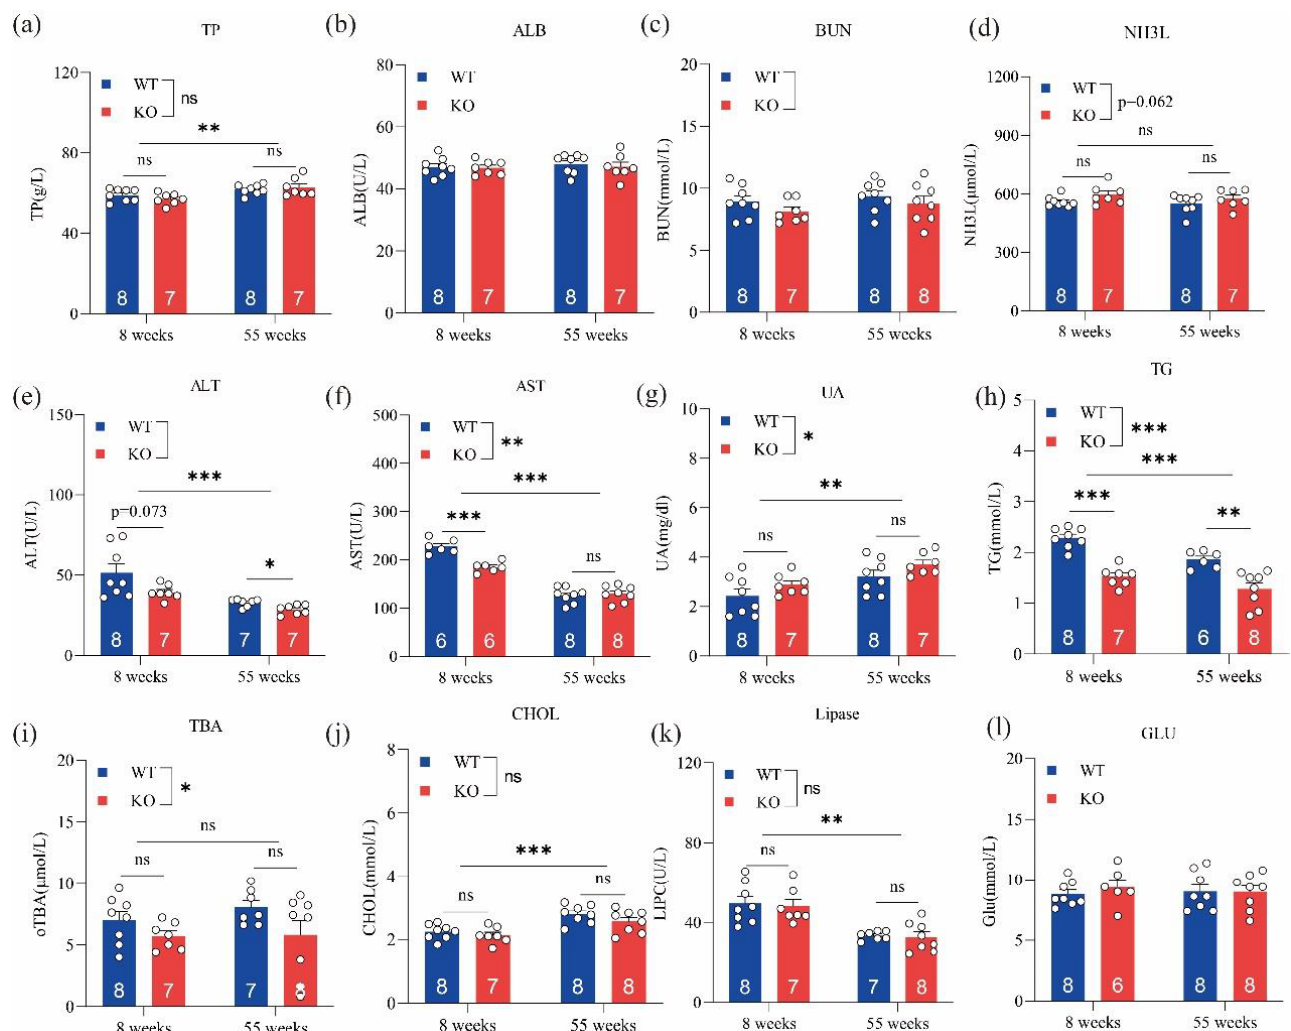
Figure 2. Effects of GPRC6A deletion on serum biochemical parameters in mice at 8 and 55 weeks. Data are presented as means ± SE; ns represents not significant; * p < 0.05, ** p < 0.01, *** p < 0.001, n = 7–8. ( a ) TP (Total protein), ( b ) ALB (Albumin), ( c ) BUN (Blood urea nitrogen), ( d ) NH3L (Blood ammonia), ( e ) ALT (Alanine aminotransferase), ( f ) AST (Aspartate aminotransferase), ( g ) UA (Uric acid), ( h ) TG (Triglycerides), ( i ) TBA (Total bile acid), ( j ) CHOL (Cholesterol), ( k ) Lipase, ( l ) GLU